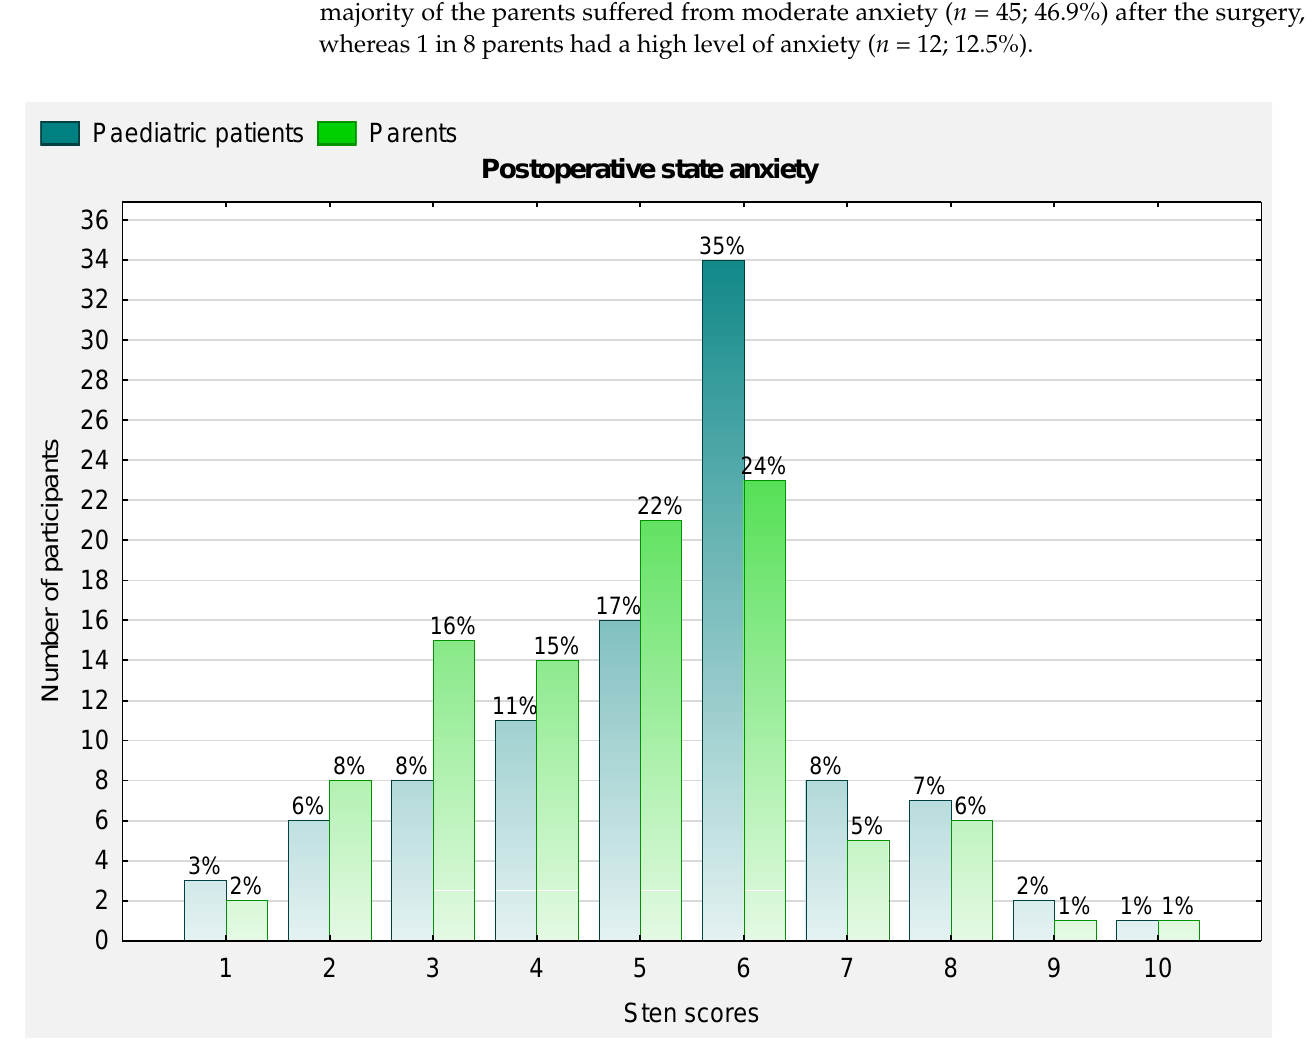
Figure 3. Histogram of the distribution of state anxiety scores in paediatric patients and parents after surgery (1–4 = low level of anxiety; 5–6 = moderate level of anxiety; ≥7 high level of anxiety). The level of state anxiety on postoperative day 3 was significantly lower than before surgery in both the patients (median 6 [4; 6] vs. 6 [5; 7]; Z = 5.45; p < 0.001) and parents (5 [3; 6] vs. 6 [5.5; 8]; Z = 6.11; p < 0.0001). The results of the correlation studies show that a moderate positive correlation exists between the trait and postoperative state anxiety scores of the patients (rho = 0.43; t = 4.64; p < 0.001), whereas, in the parents, the correlation between these variables was weak (rho = 0.32; t = 3.25; p = 0.001). There were significant weak positive correlations between the state anxiety scores of the parents and the pre- (rho = 0.30; t = 3.01; p = 0.003) and postop- erative anxiety scores of the children (rho = 0.26; t = 2.64; p = 0.009). The median anxiety scores of the boys’ parents were lower compared to the girls’ parents (5 [3; 6] vs. 6 [5.5; 7.5]; Z = −2.61; p = 0.009). The results of this study reveal that there are no significant correlations between the levels of postoperative state anxiety of the patients and the values of their haemodynamic parameters (heart rate, systolic and diastolic blood pressure) ( p > 0.05). 3.3.1. Factors Related to the Postoperative State Anxiety of Paediatric Patients The multiple linear regression model for the state anxiety of the children and adoles- cents after surgery (Table 4) is statistically significant ( p < 0.001) and explains 36% of the variance in the patients’ anxiety. The average postoperative pain at rest, trait anxiety of the patients and high level of preoperative state anxiety (vs. low and moderate) have a positive impact on postoperative anxiety. However, the patients’ age negatively correlates with anxiety.